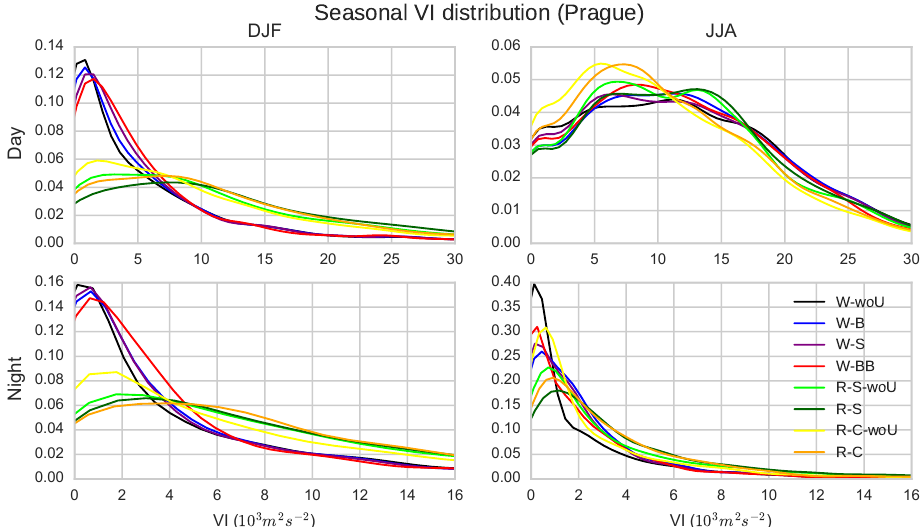
Figure 14. Seasonal distributions of the Ventilation Index (VI; in 10 3 m 2 s − 2 ) for the city of Prague, given by all simulations. The day represents the time between 11:00 and 16:00UTC; the night represents the time between 23:00 and 04:00UTC. The y coordinate marks values of the estimated density function of the